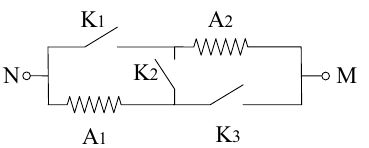
Figure 36 Distribution diagram of winding changeover switches